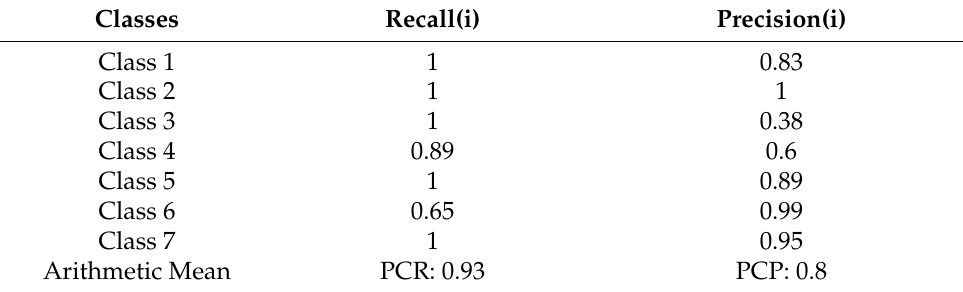
Table 4. The precision for each of class three and class four is low similar to the recall of class six. In Table 5 we show the hybrid confusion matrix in which the rows and columns represent the input and predicted classes respectively. The true positives are highlighted for better visibility. Table 4. PCR and PCP for independent classifiers.